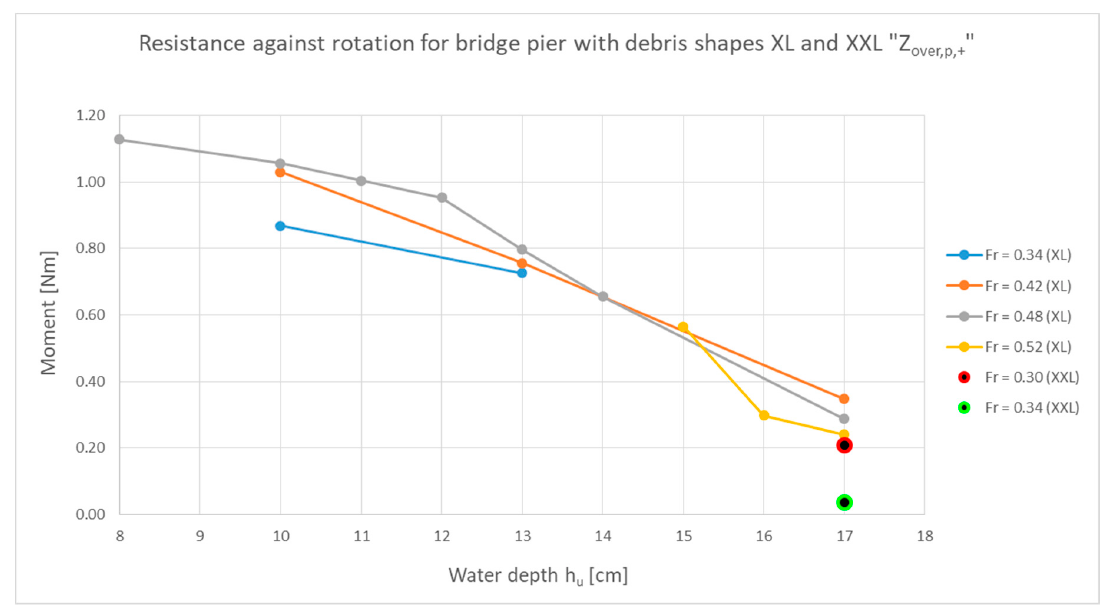
Figure 13. Self-weight restoring moment of the pier (about the heel of the pier) minus the hydrodynamic overturning moment, as measured by the load cell. The only observed failure in the free standing experiments is indicated by the green circle.